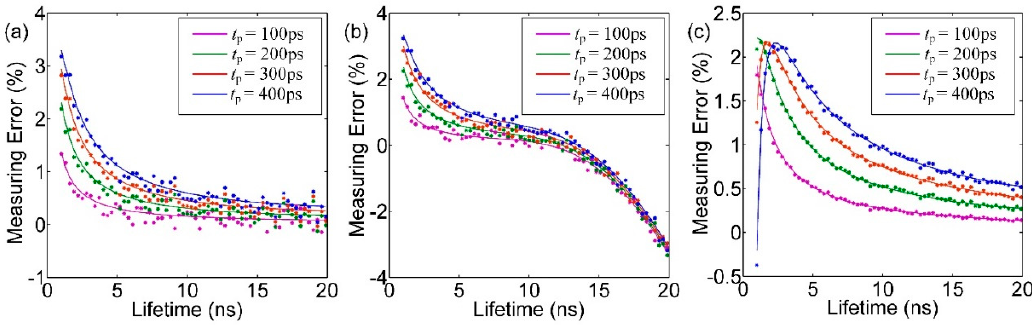
Figure 8. The relationship between measuring error of different lifetimes and t p while using ( a ) MLE; ( b ) CMM; ( c ) LSM to estimate lifetimes.